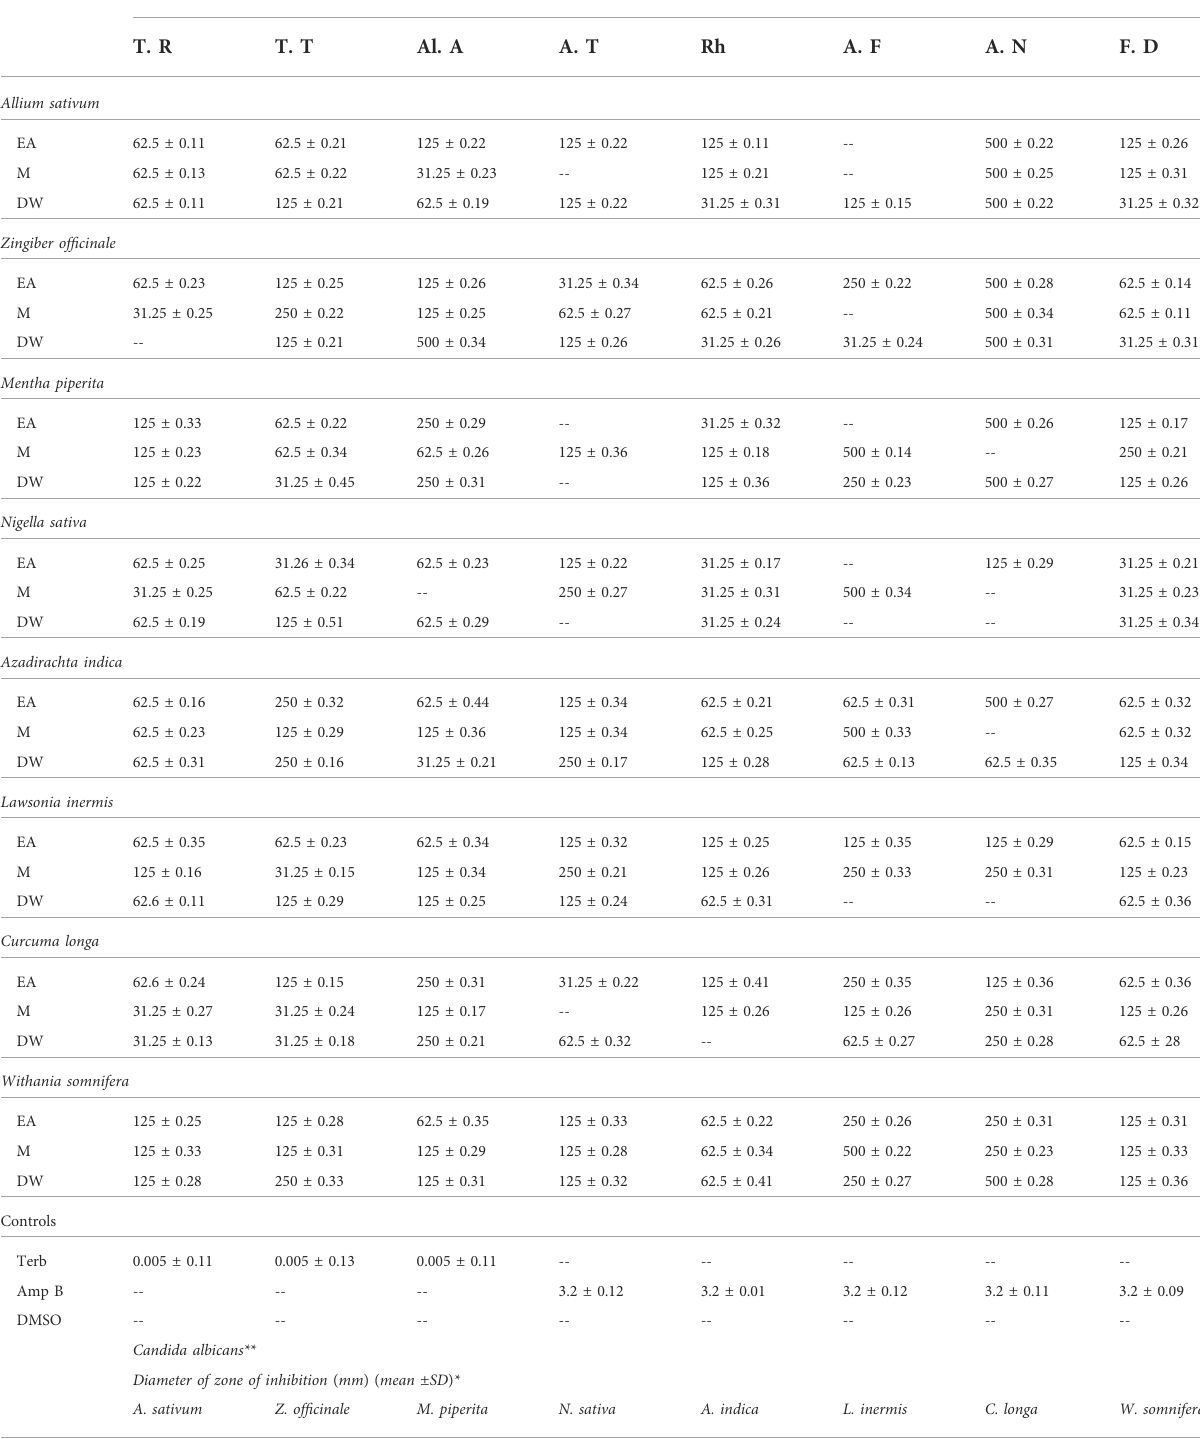
TABLE 5 Antifungal potential of tested extracts against dermatophytes and non-dermatophytes.